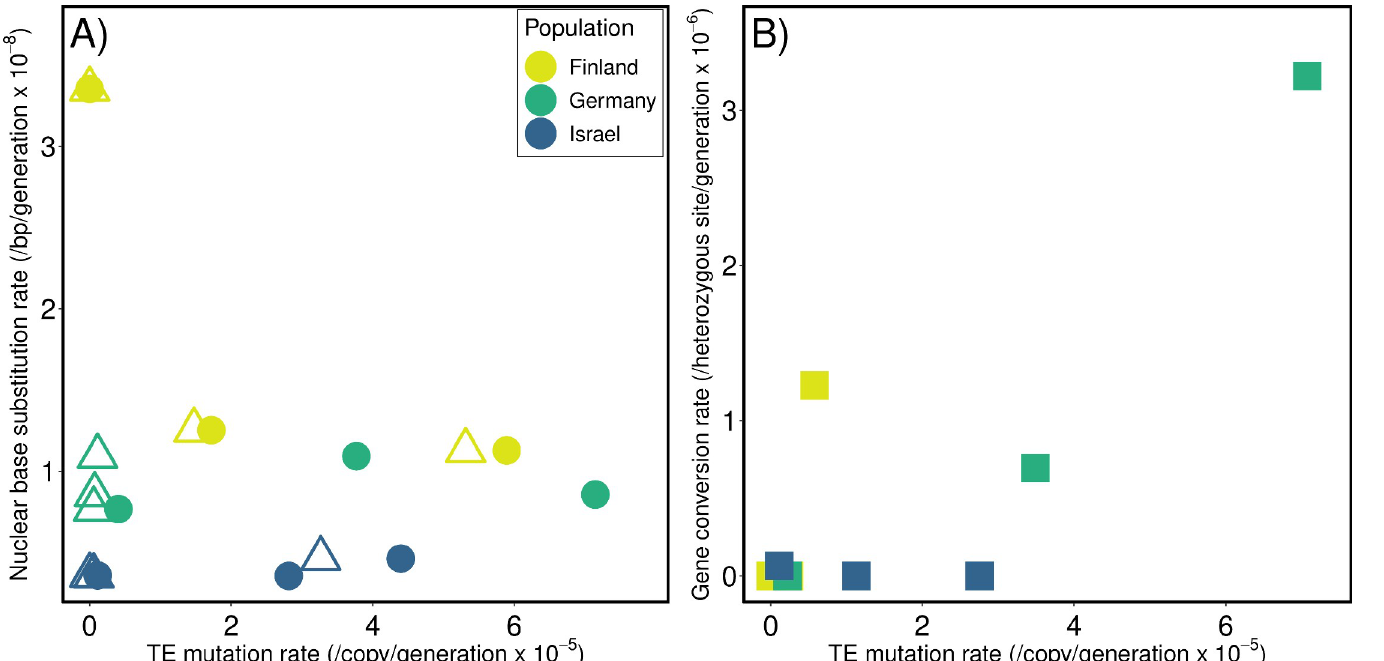
Fig 4. The relationship between TE, base substitution, and gene conversion mutation rates in D . magna MA lines. (A) Base substitution rates (per bp per generation) plotted against TE mutation rates (per copy per generation). Circles represent the sum of all TE gains and losses, triangles represent only 0 ! 1 TE gains. (B) Gene conversion rates are plotted against TE events that could be caused by gene conversion (the sum of 1 ! 0 TE losses and 1 ! 2 TE gain rates; shown as squares). Points in gold, green, and blue represent rate estimates for genotypes collected from Finland, Germany and Israel, respectively. Base substitution and gene conversion rates are from